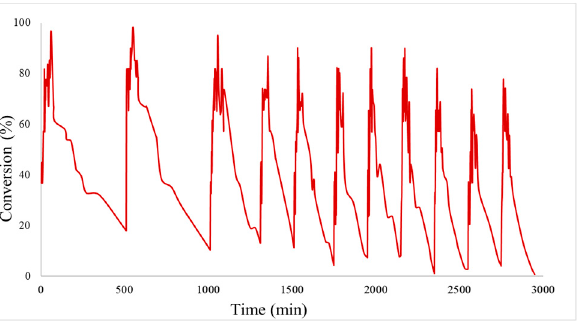
Figure 11. Conversion versus time plot for the reusability study performed in continuous flow. Reaction conditions: temperature = 30 °C; pressure = 1 bar; inlet flow = 0.05 mL/min; 0.1 g catalyst of 5 wt.% Pd on carbon.